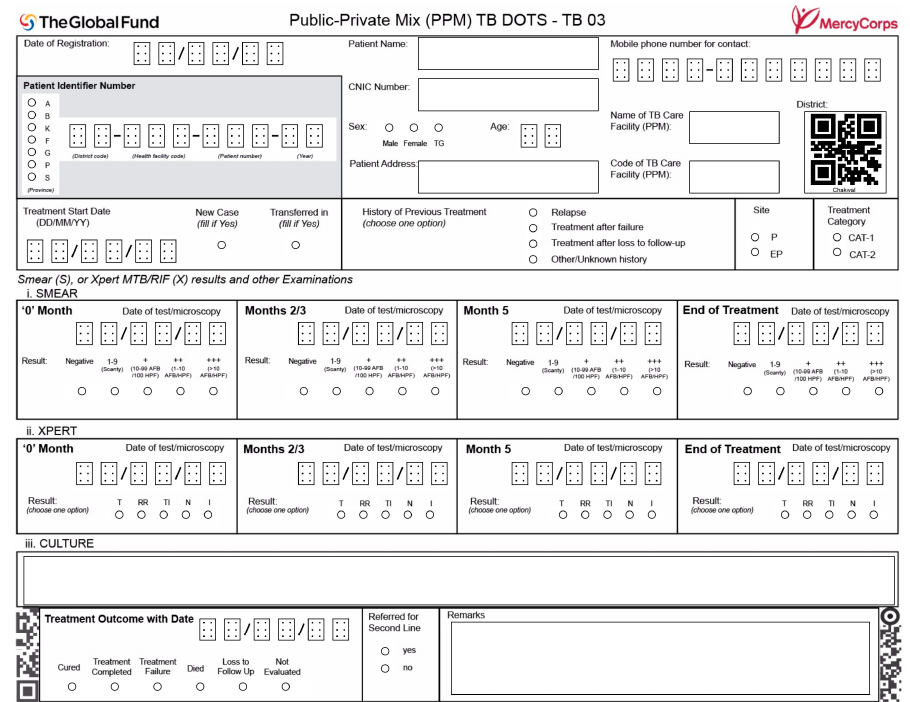
Figure 2. Scan ‐ compatible TB03 form used in ODK Scan paper ‐ to ‐ digital system displaying fill ‐ in bubbles, number boxes and text fields.